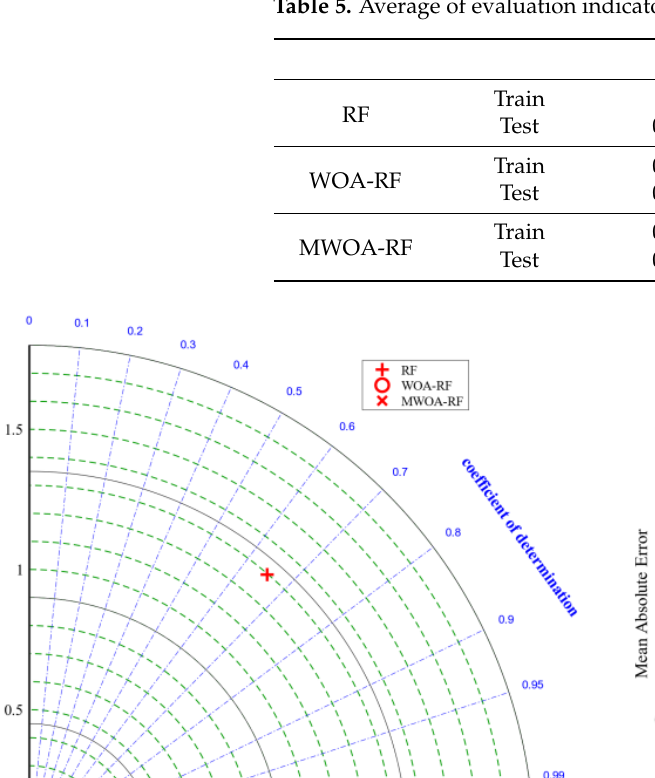
Table 5. Average of evaluation indicators for three RF models.